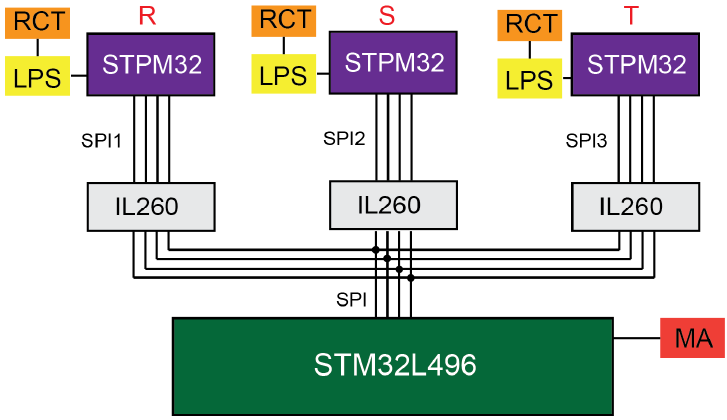
Figure 41. Extension of the implemented single-phase setup for measurements in three-phase systems. Table 5. Main components in the setup of Figure 40.